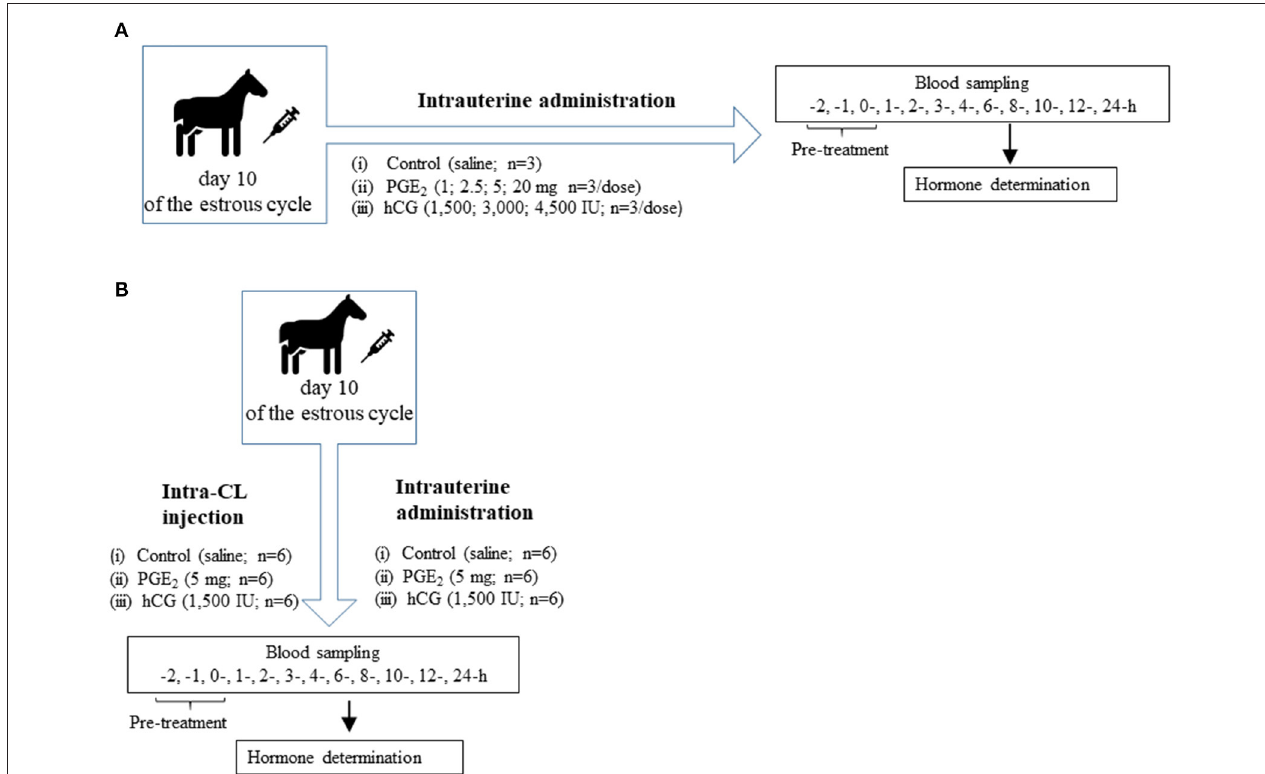
FIGURE 1 | (A) Schematic diagram of experiment 1. Mares on day 10 of the estrous cycle were managed as follows: (1) One intrauterine saline administration (control group; n = 3); (2) One intrauterine administration of prostaglandin (PG) E 2 (PGE 2 ; 1 mg/5ml, 2.5 mg/5ml, 5 mg/5ml, 20 mg/5ml; n = 3 per dose); (3) One intrauterine administration of human chorionic gonadotropin (hCG; positive control; 1,500 IU/5ml; 3,000 IU/5ml, 4,500 IU/5ml; n = 3 per dose). After treatment (0h), blood plasma samples were collected for 24h throughout the experiment. (B) Schematic diagram of experiment 2. Mares on day 10 of the estrous cycle were managed as follows: (1) One intra-CL saline injection (control; n = 6); (2) One intra-CL injection of PGE 2 (5 mg/ml; n = 6); (3) One intra-CL injection of hCG (positive, control; 1,500 IU/ml; n = 6); (4) One intrauterine saline administration (control group; n = 6); (5) One intrauterine administration of PGE 2 (5 mg/5ml; n = 6); (6) One intrauterine administration of hCG (positive control; 1,500 IU/5ml; n = 6). After treatment (0h), blood plasma samples were collected for 24h throughout the